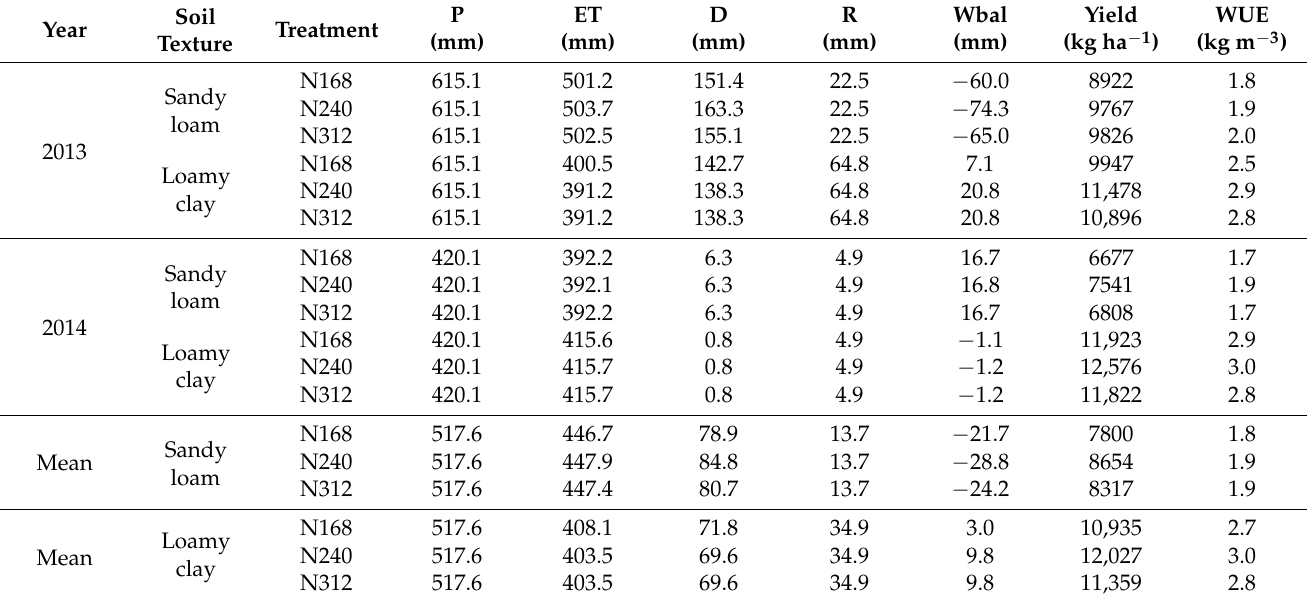
Table 2. Water balance and water use efficiency in 100 cm soil profiles under different N rates for two textural soils in 2013 and